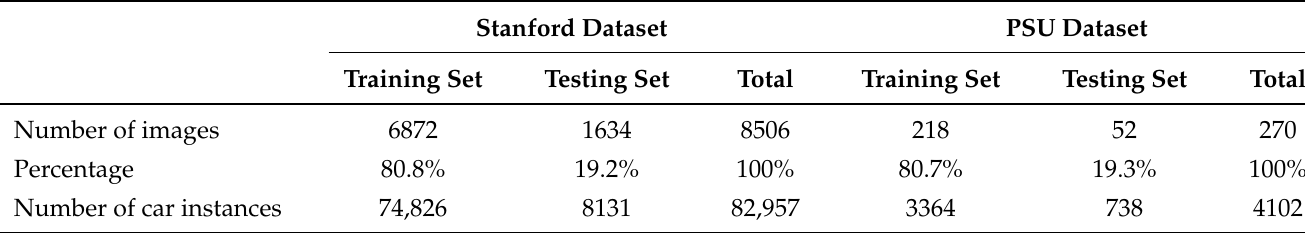
Table 3. Number of images and car instances in Stanford and PSU (Prince Sultan University) datasets.